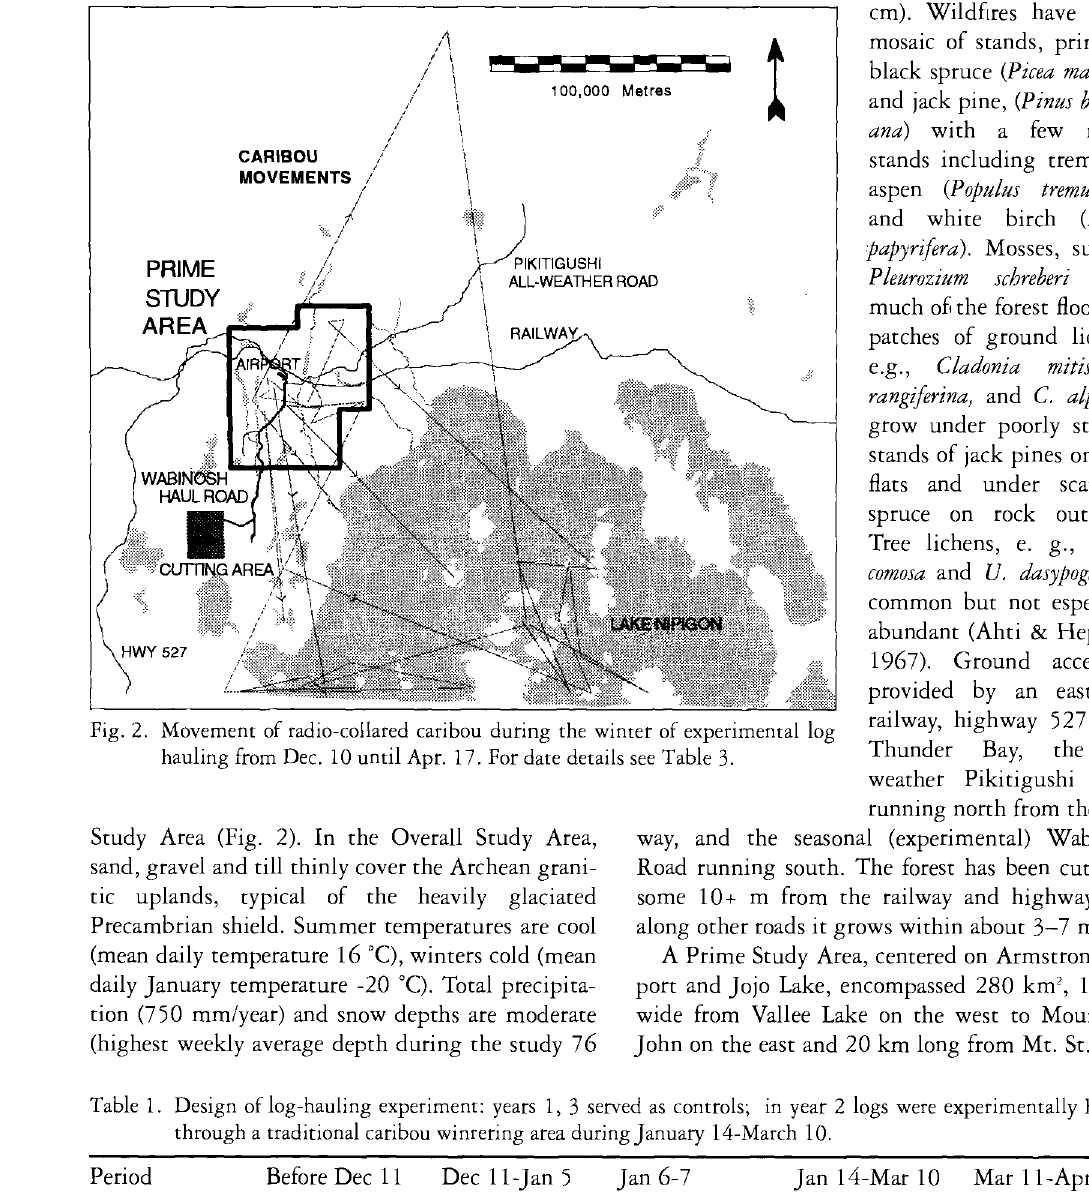
Table 1. Design of log-hauling experiment: years 1, 3 served as controls; in year 2 logs were experimentally hauled through a traditional caribou winrering area during January 14-March